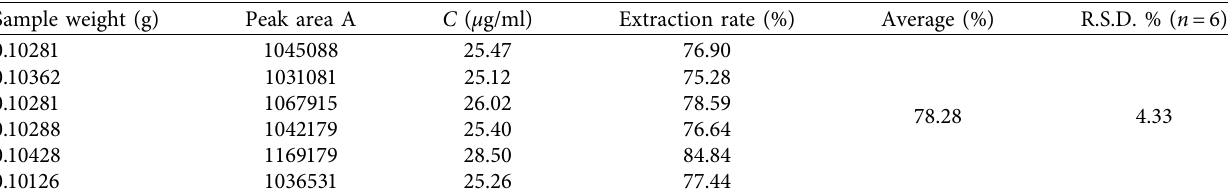
Table 5: Results of the extraction.